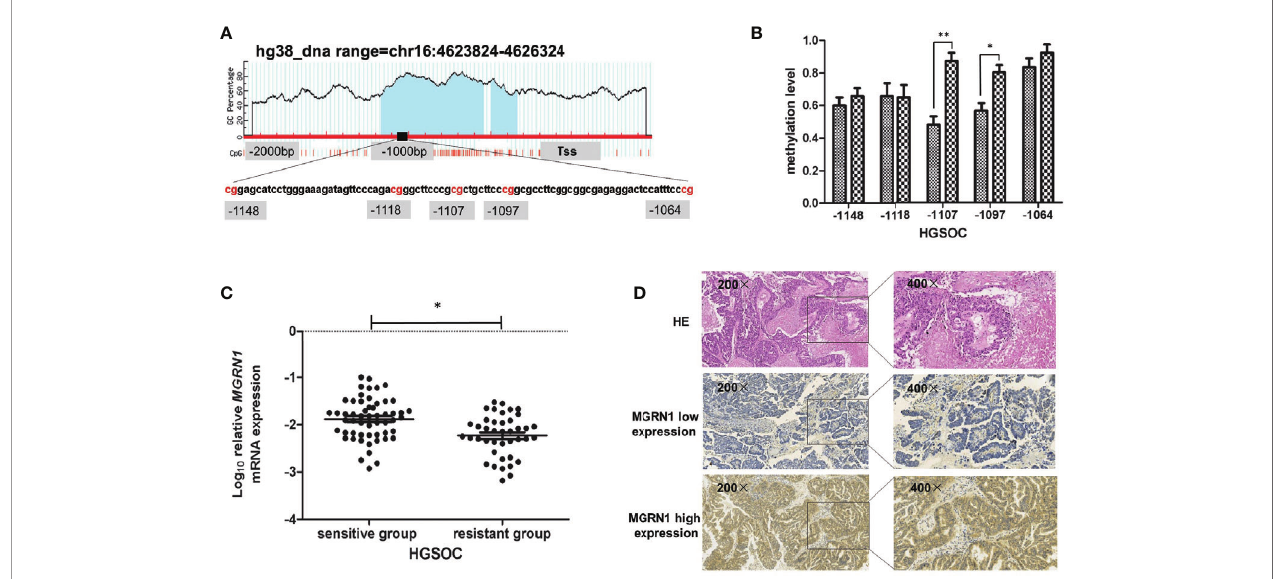
FIGURE 1 | The methylation level of MGRN1 promoter was associated with platinum-resistant in HGSOC patients. (A) Schematic diagram of the abnormal methylation region (-1148 to -1064 upstream) in the promoter region of the MGRN1 gene. (B) The methylation of -1107 and -1097 CpG site were signi fi cantly hypermethylated in platinum-resistant HGSOC tissues compared with platinum-sensitive HGSOC tissues by MALDI-TOF Sequenom MassARRAY. (C) The mRNA expression of MGRN1 was lower in platinum-resistant HGSOC patients than platinum-sensitive HGSOC patients. (D) MGRN1 protein expression in HGSOC tissues. * P < 0.05, ** P <